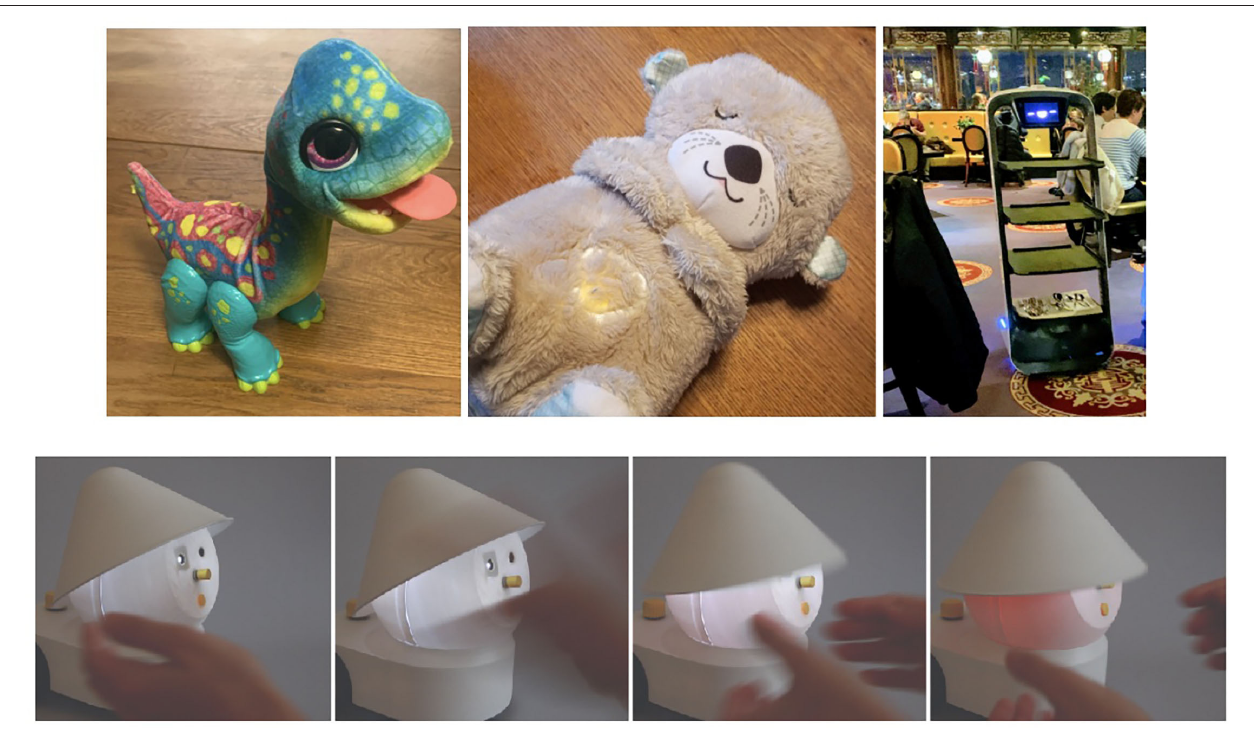
FIGURE 3 | (Top) Hasbro’s “Snackin’ Sam” appears to engage children through motor resonance: articulating its neck, jaw and tongue to show interest in eating a popsicle. The Fisher-Price “Soothe’n’Snuggle” appears to support child sleep through rhythmic entrainment to its in-and-out breathing pattern. A Pudo brand robot delivers food in a restaurant, using periodic facial expressions to create a friendly vibe. (Bottom) The Shybo robot expresses emotions through movement; this sequence shows the robot reacting to the loud sound of a clap by closing the hat, shaking it and lighting up in